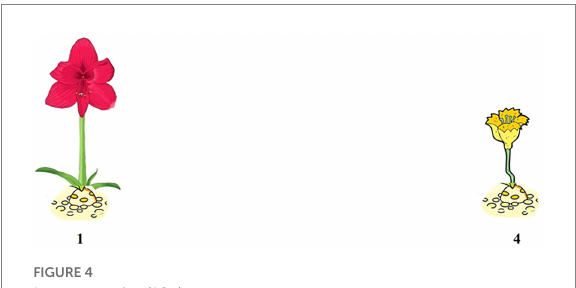
FIGURE 4 Last scene for (12e).